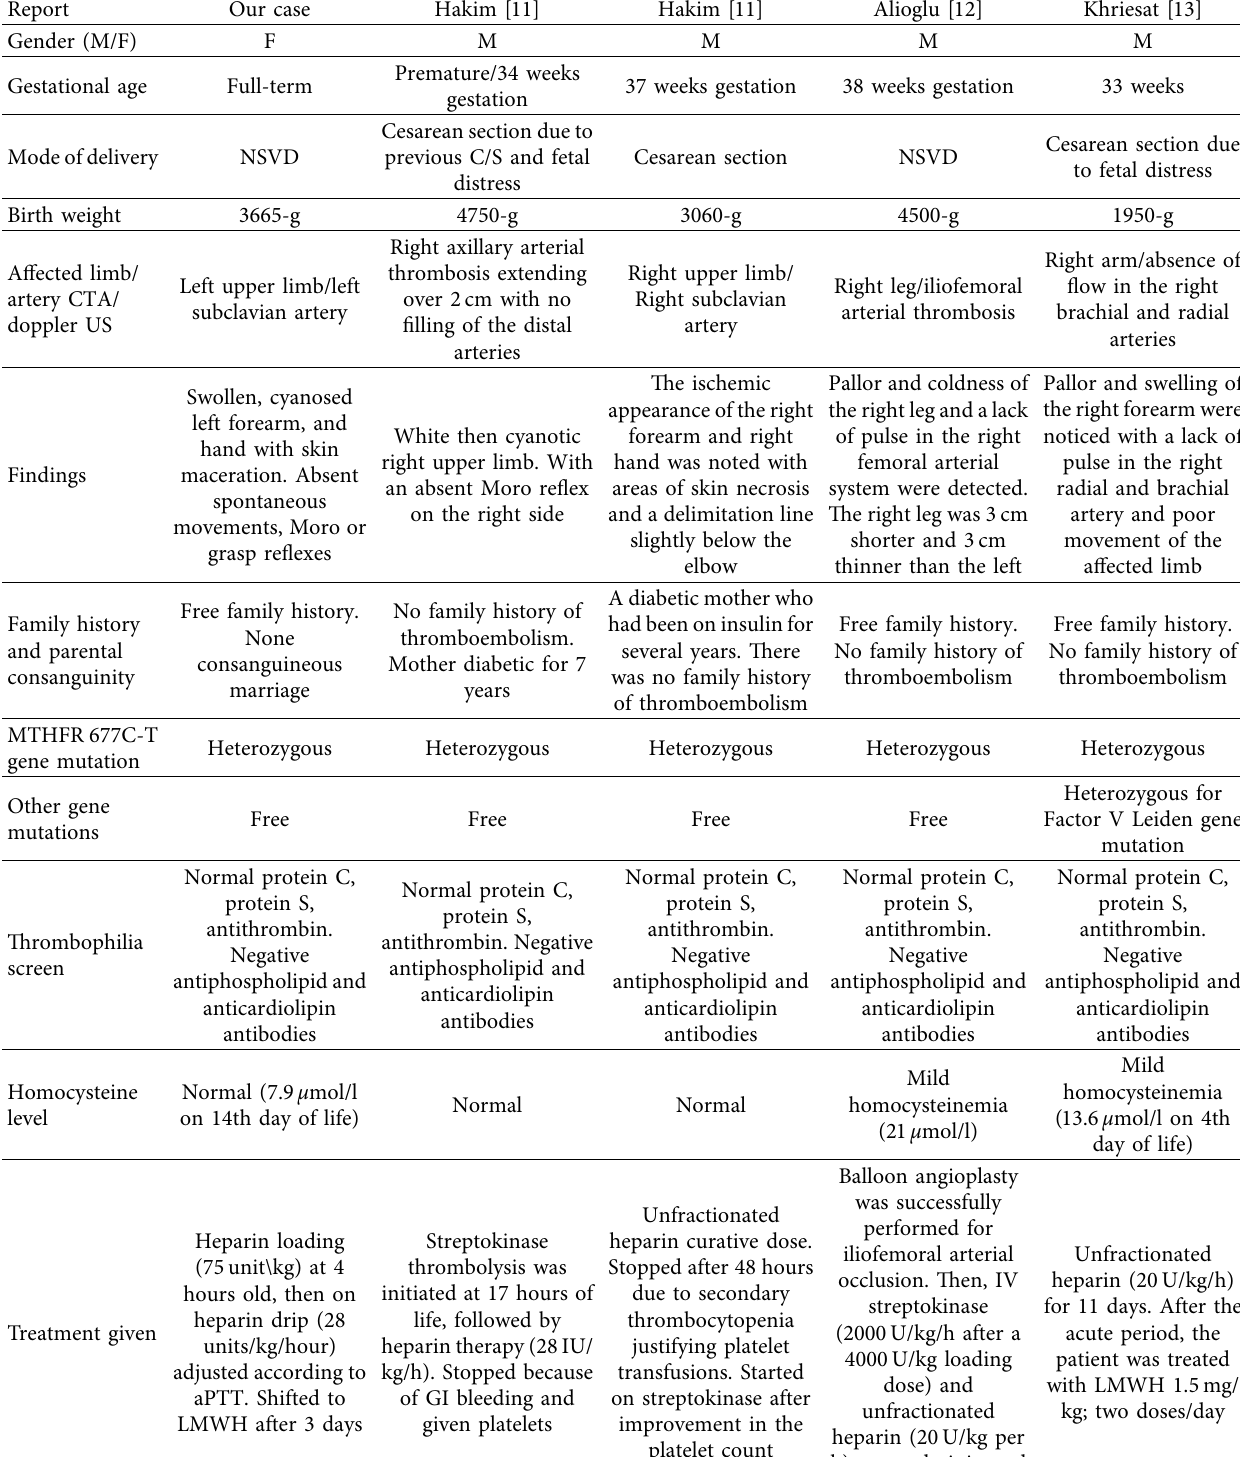
Table 1: Summary of the clinical findings, laboratory investigations, treatment provided, and outcome in our patient and other patients diagnosed with intrauterine limb thrombosis and were found to be heterozygotes for the MTHFR 677C-T gene mutation.